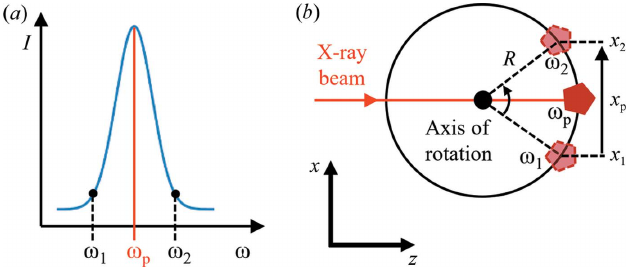
Figure 2 Alignment for the longitudinal position in the depth-resolved Bragg CDI. ( a ) After the x and y coordinates have been aligned, the Bragg peak intensity is scanned with the ! -scan rotation providing the rocking curve data. Then, x profiles are measured on the opposite sides of that curve: ! 1 and ! 2 . ( b ) If the particle was seated off the axis of rotation, the x position of the peak would shift between these two scans. The misalignment along the beam direction is calculated as the amount of that shift divided by the angular difference expressed in